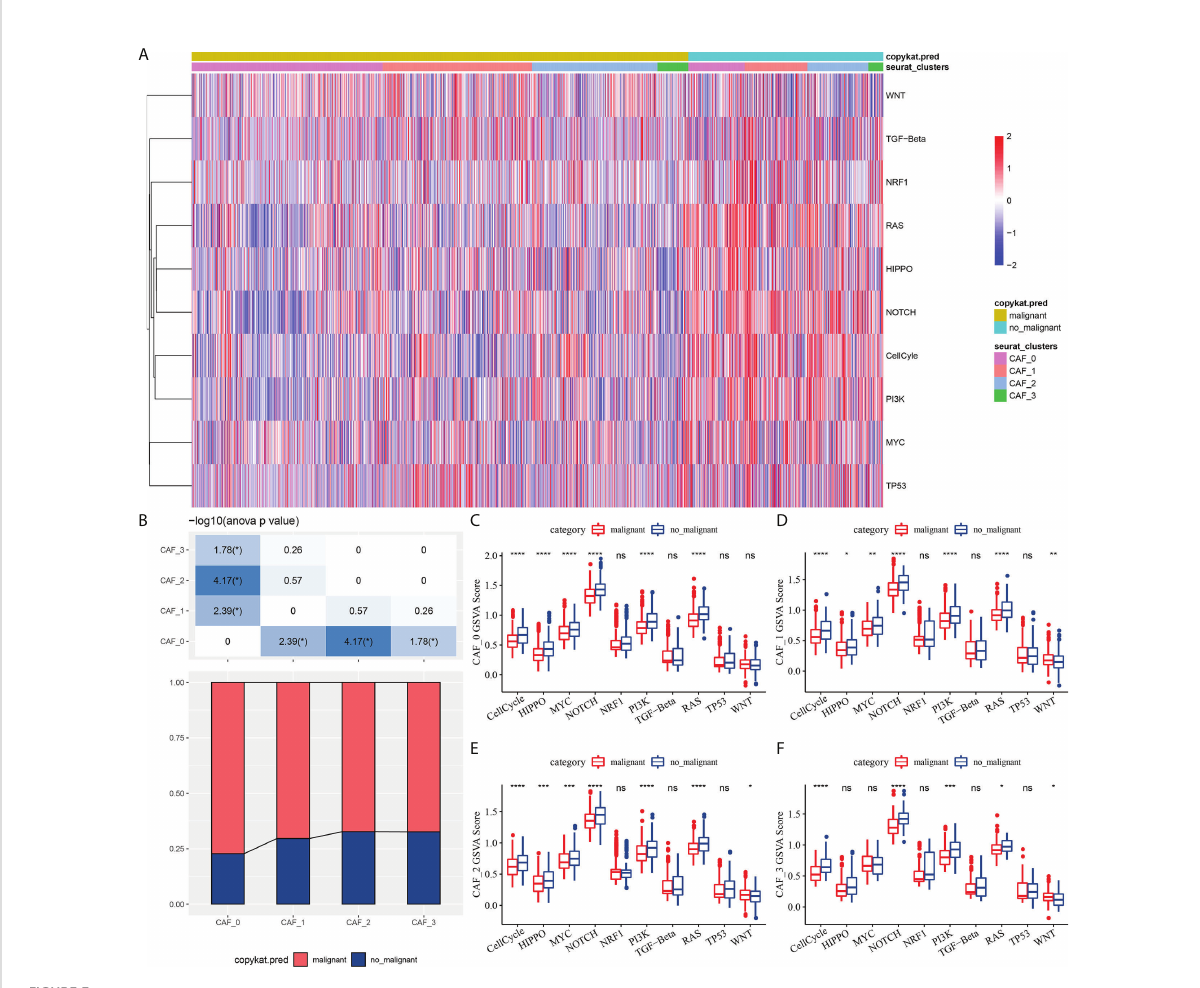
FIGURE 3 The characteristics of tumor-related pathways in CAF clusters. (A) Heatmap of 10 tumor-related pathway scores enriched in CAF cells; (B) Comparison of CAF clusters in malignant and non-malignant cells; Comparison of GSVA score of each pathways between malignant and non- malignant cells in CAF_0 (C) , CAF_1 (D) ,CAF_2 (E) , and CAF_3 cluster (F) . (wilcox.test, *P < 0.05; **P < 0.01; ***P < 0.001; and ****P < 0.0001). ns, not signi fi